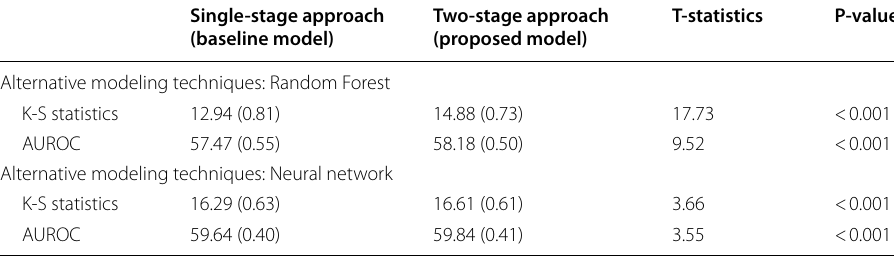
Table 6 Summary of the robustness test Single‑stage approach (baseline